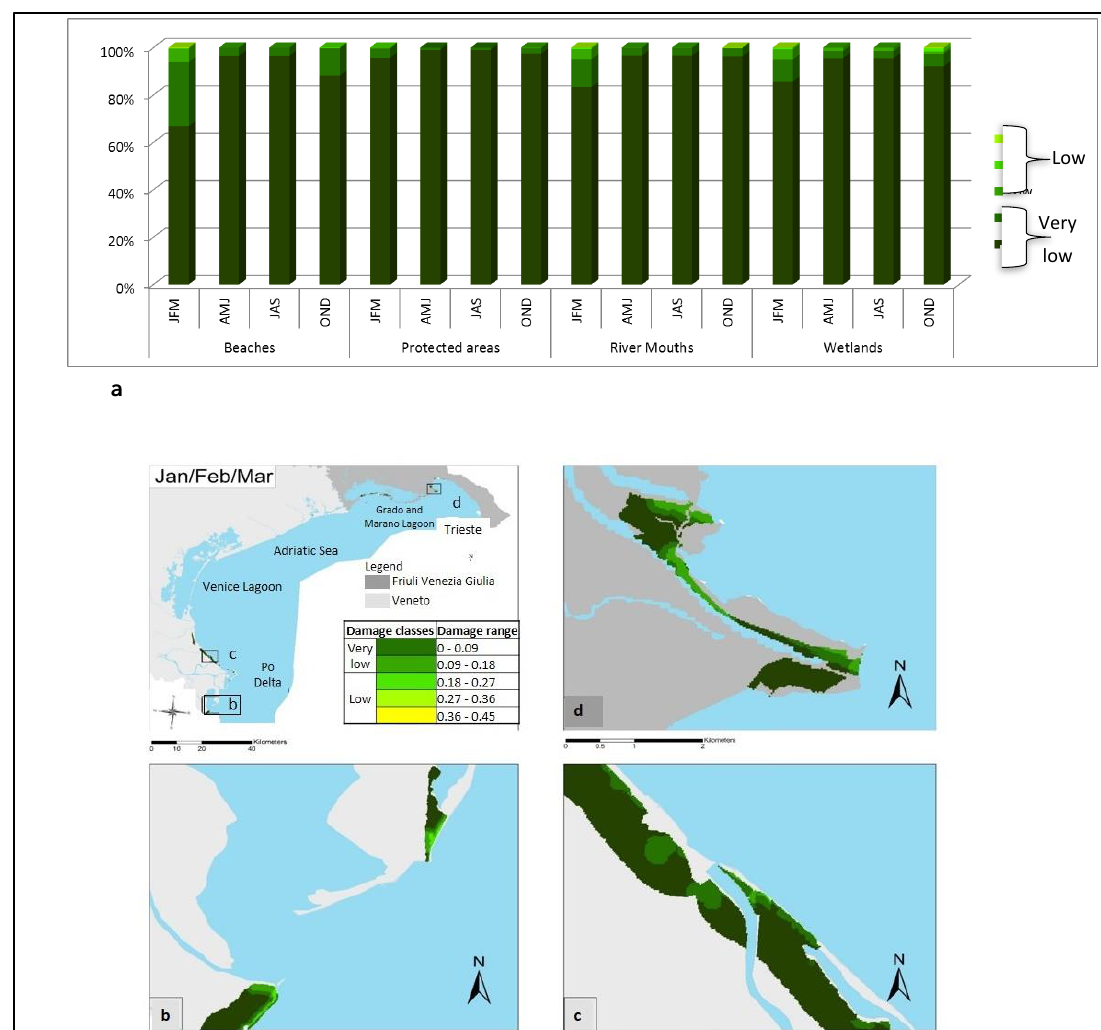
Figure 5. Percentage of receptors’ surface in each damage class for the 4 seasons ( January-February- March JFM; April-May-June AMJ; July-August-September JAS; October-November-December OND) of the future scenario 2070 – 2100 ( a ); example of damage map for wetlands in the trimester Jan/Feb/Mar ( b – d ).